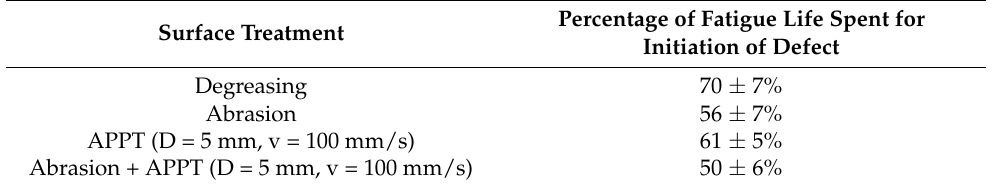
Table 7. Percentage of fatigue life spent for initiation of defect for the considered